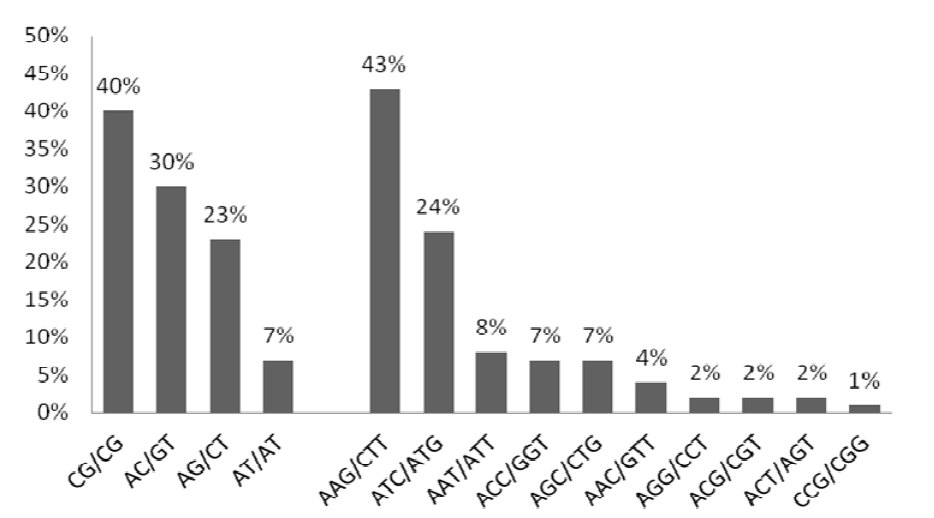
Figure 1. Frequency distribution of microsatellites in P. ovata based on the di-repeat and tri-repeat motif sequence